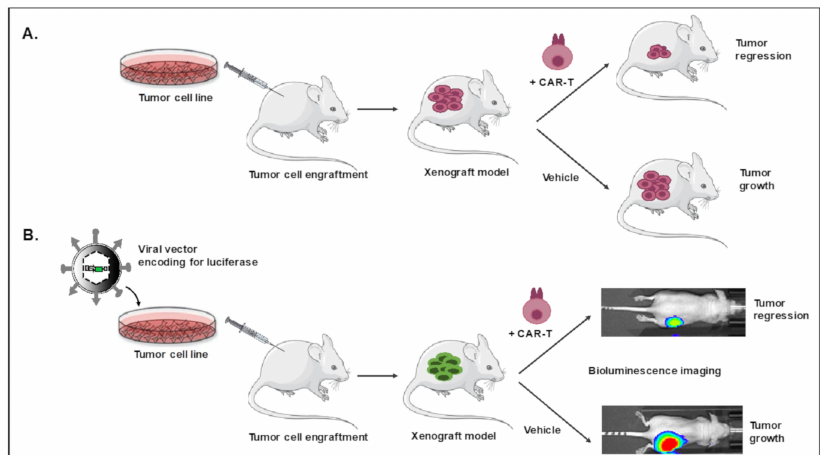
Figure 2. Tumor cell xenografted humanized mice for CAR T cell evaluation. Tumor cell lines not transduced ( A ) or transduced ( B ) with a vector encoding for the reporter gene, luciferase, are